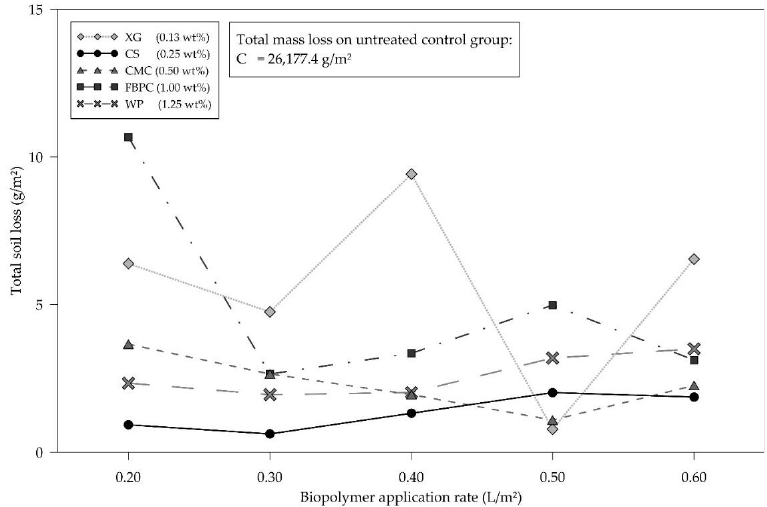
Figure 7. Total soil loss (g/m 2 ) of fine-grained silica sand samples treated at their plateau concentration at different biopolymer application rates after the fifth wind tunnel cycle. Tests were performed in triplicate (n = 3). Note, numerical data (mean (M) and standard deviation (SD)) are appended in Table A2. Error bars representing the SD have been deliberately omitted for better legibility.